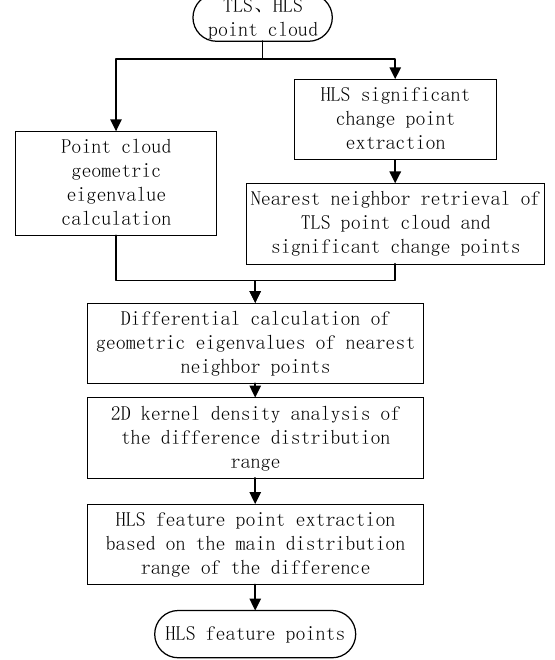
Figure 2. HLS point cloud feature point filtering flowchart.